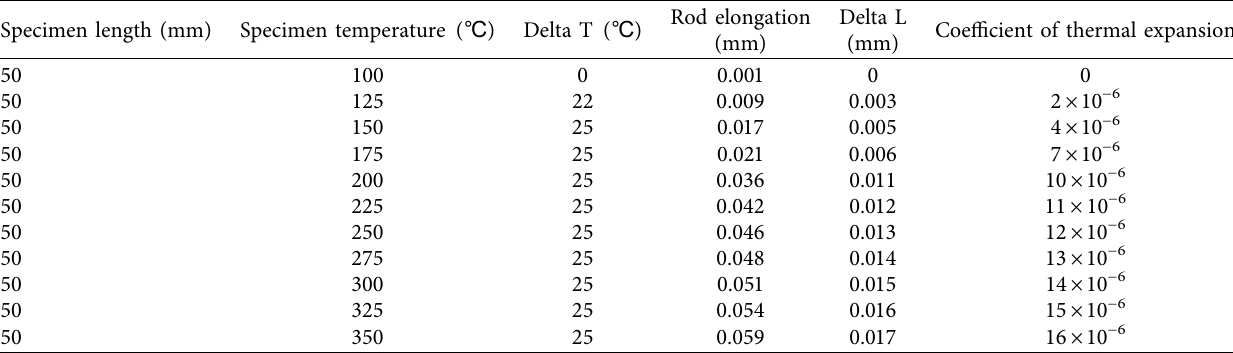
Table 13: CTE of the Ni-Cu alloy +12% TiO